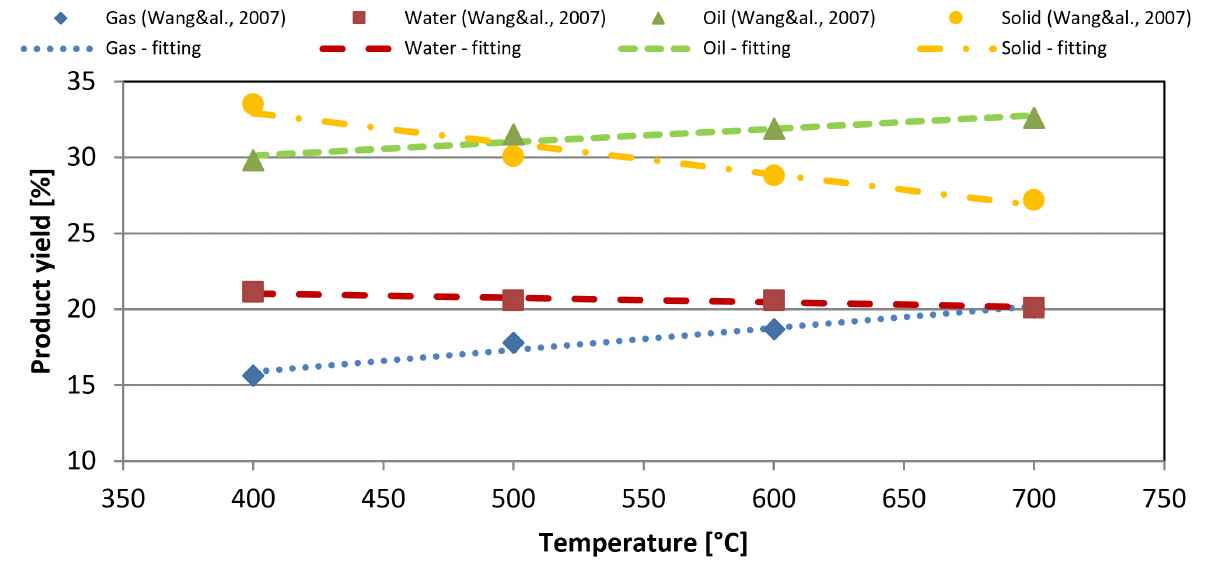
FIGURE 1 | Comparison between simulation results and literature data (Wang et al., 2007).